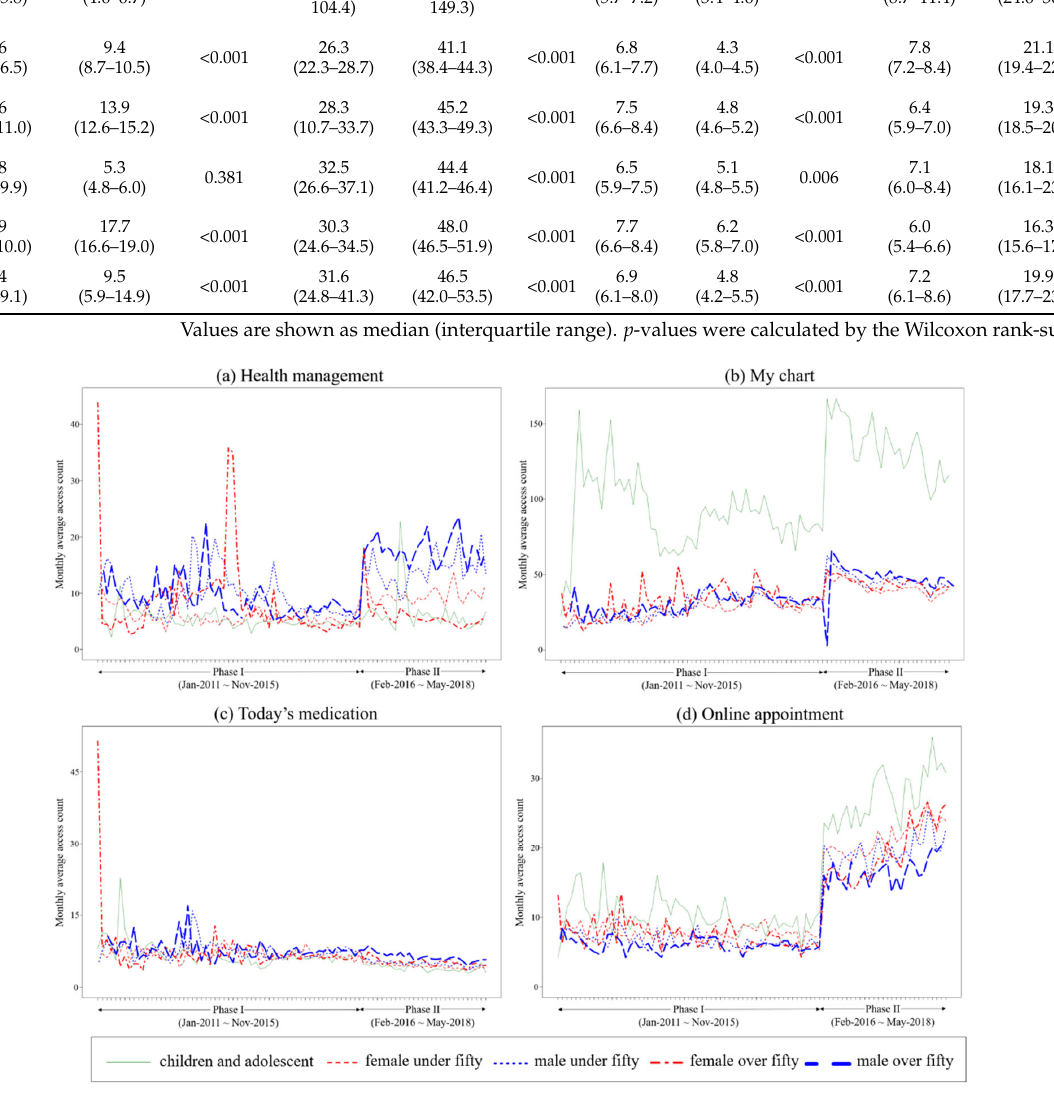
Figure 4. Monthly average access counts of ( a ) “Health Management” menu, ( b ) “My Chart” menu, ( c ) “Today’s Medication” menu, and ( d ) “Online Appointment” menu according to age and sex groups.